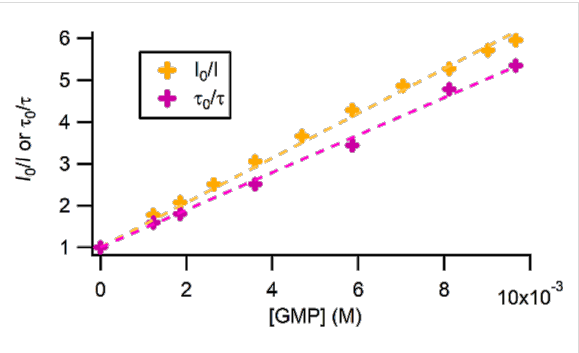
Figure 4: Luminescence intensity and excited state lifetime of conju- gate 9 in the presence of GMP measured in 10 mM Tris·HCl buffer at pH